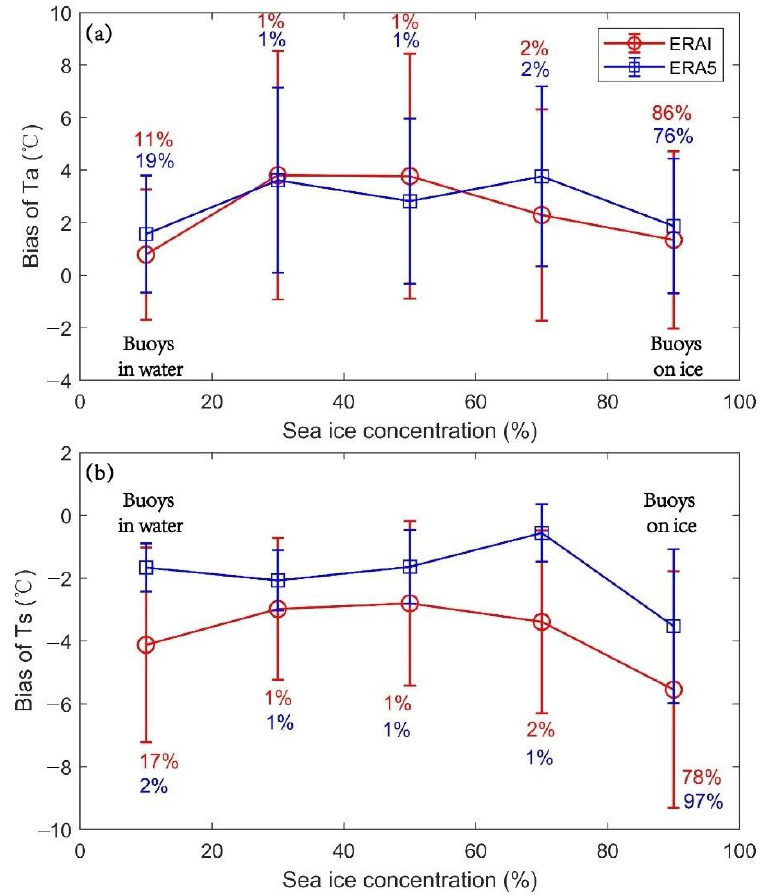
Figure 12. The Ta ( a ) and Ts ( b ) biases in the different SIC (sea ice concentration) ranges. The red lines and blue lines represent the ERA-I and ERA5, respectively. The red and blue numbers represent the percentages of the buoys used in the calculations.